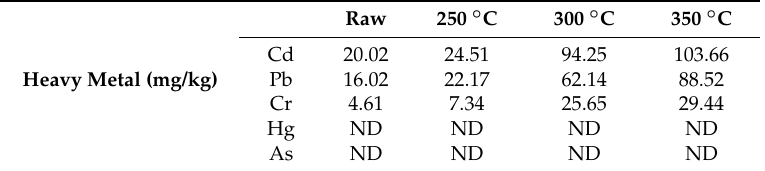
Table 3. Heavy metal concentration of WW as a function of the torrefaction